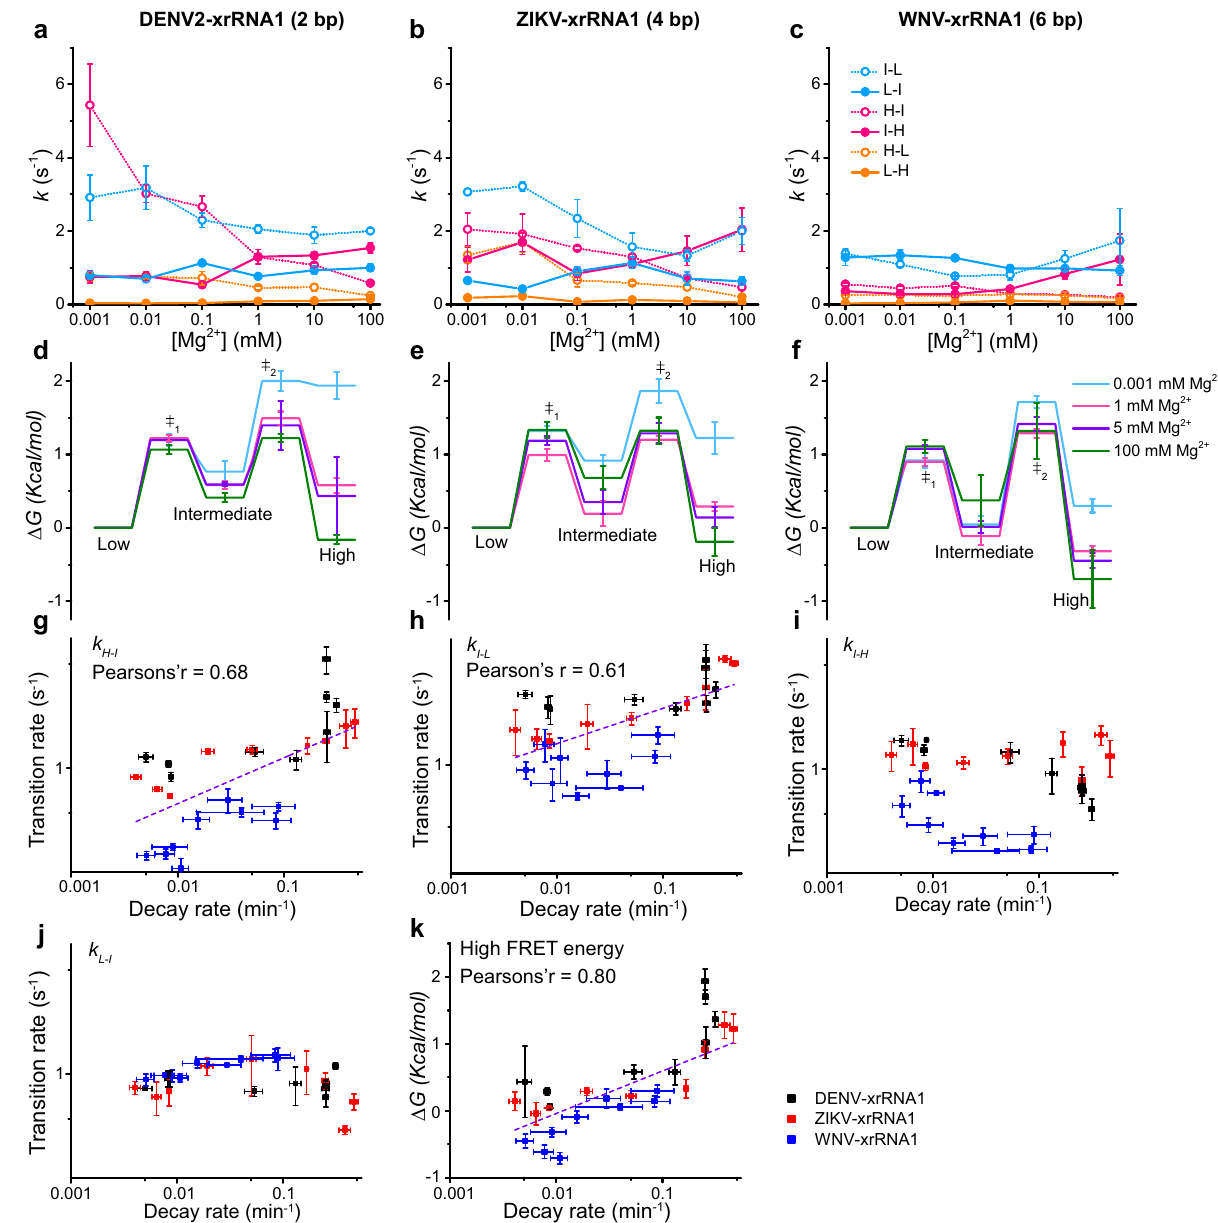
Fig. 4 Mg 2 + -dependent folding kinetics of fl aviviral xrRNAs. a – c Transition rate constants among the L state , I state , and H state states for DENV2-xrRNA1 ( a ), ZIKV-xrRNA1 ( b ), and WNV-xrRNA1 ( c ) were plotted against Mg 2 + concentrations. d – f Free-energy diagrams for the Mg 2 + -dependent folding of DENV2- xrRNA1 ( d ), ZIKV-xrRNA1 ( e ) and WNV-xrRNA1 ( f ) at various Mg 2 + concentrations. g – j Correlation analysis of Xrn1 decay rates with the transition rates of k H – I , k I – L , k I – H , and k L – I of xrRNAs at various Mg 2 + concentrations. k Correlation analysis of the free energy of H state with Xrn1 decay rates of xrRNAs at various Mg 2 + concentrations. Data are presented as mean ± SEM. Error bars are SEM of three independent experiments ( n = 3) in a – k . Source data are provided as a Source Data fi le.